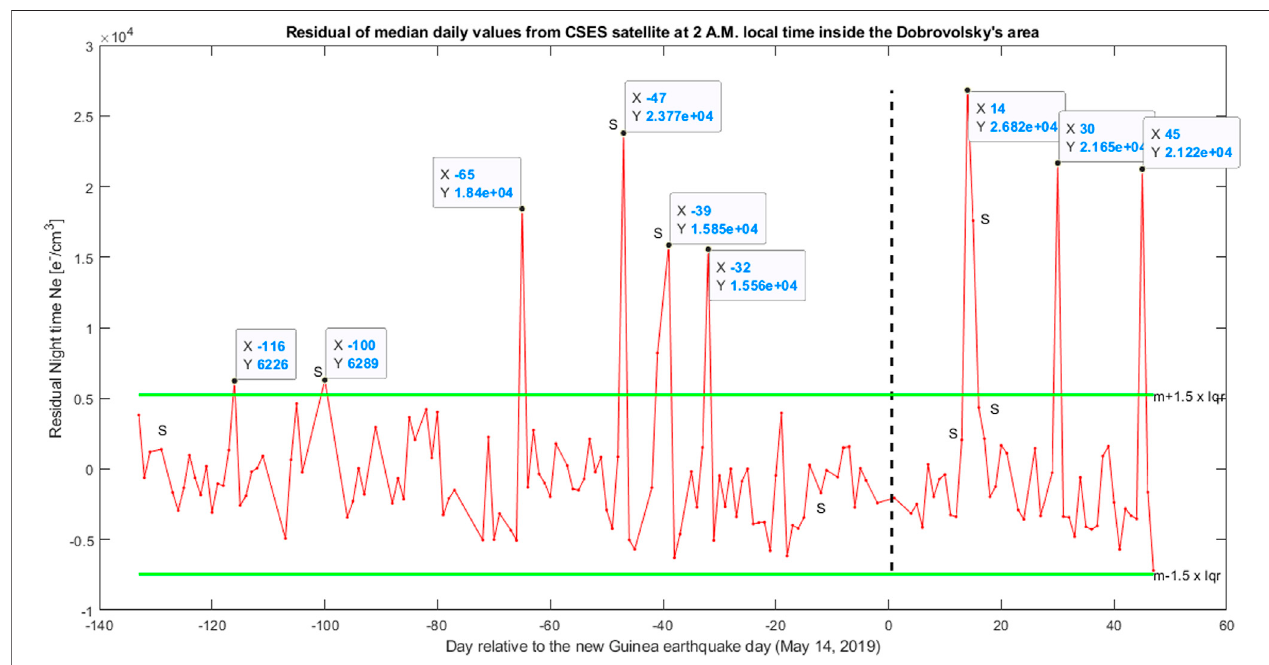
FIGURE11| CSESdailymedianelectrondensityduringnighttime(2:00 a.m.).Onlydataacquiredduringgeomagneticquiettime(|Dst| ≤ 20nTanda p ≤ 10 nT)has been shown. Days with high solar activity are depicted by “ S. ”